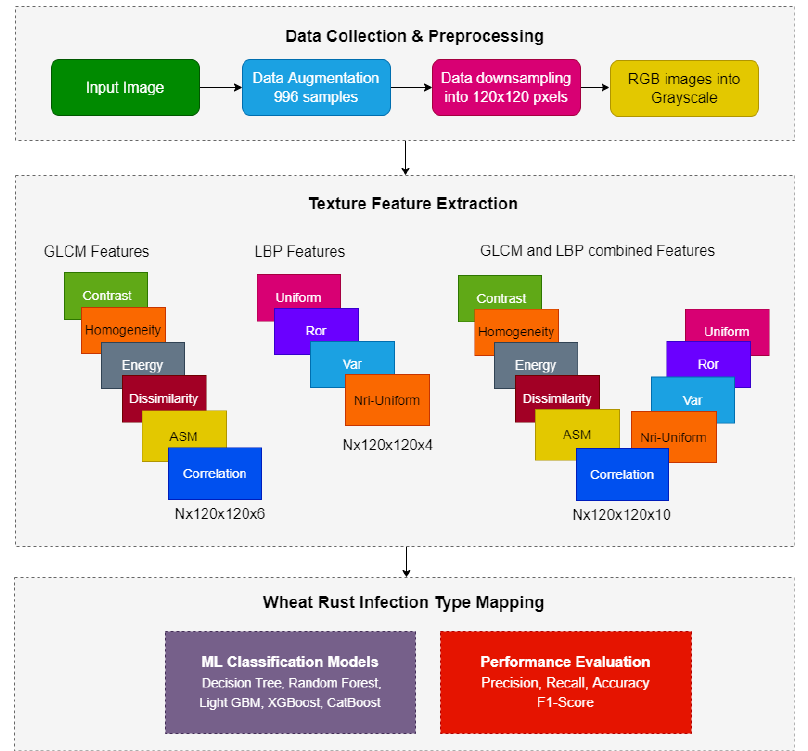
Figure 1. System architecture.